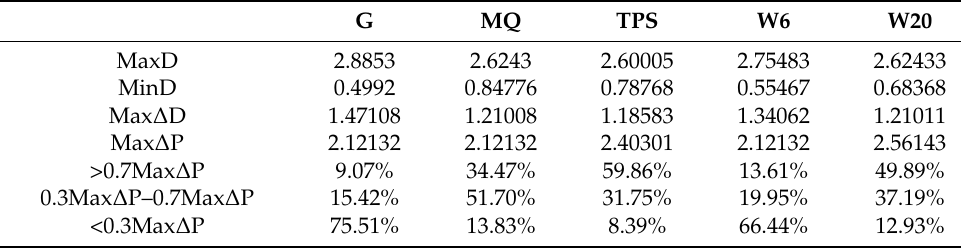
Figure 6. Expansion results obtained using the basis functions. Table 7. Comparison of the modification results.